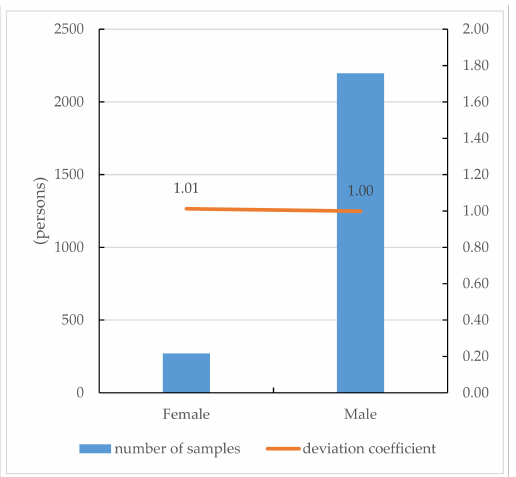
Figure 4. Deviation coefficient of agricultural machinery utilization rate grouped by